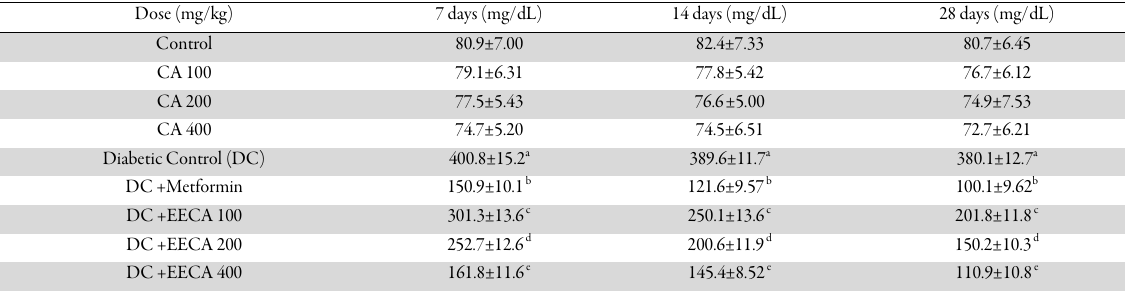
Table 4. Effect of Chrysophyllum albidum on glucose level of alloxan-induced diabetic rats Dose